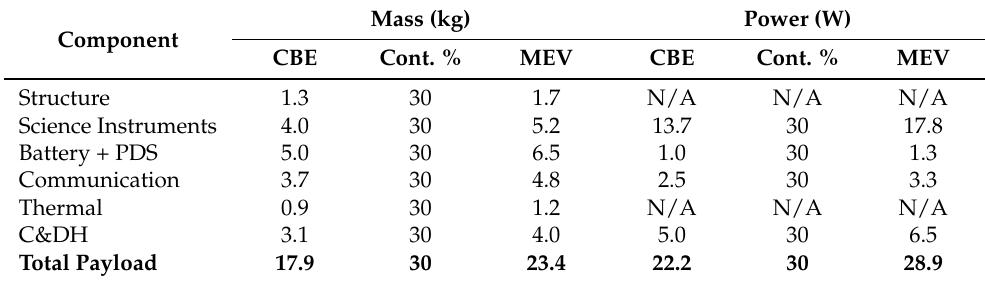
Figure 9. A schematic of a gondola for the Habitability Mission. Non-science subsystems, except for the antenna, are not shown. Table 4. Habitability Mission gondola mass and power